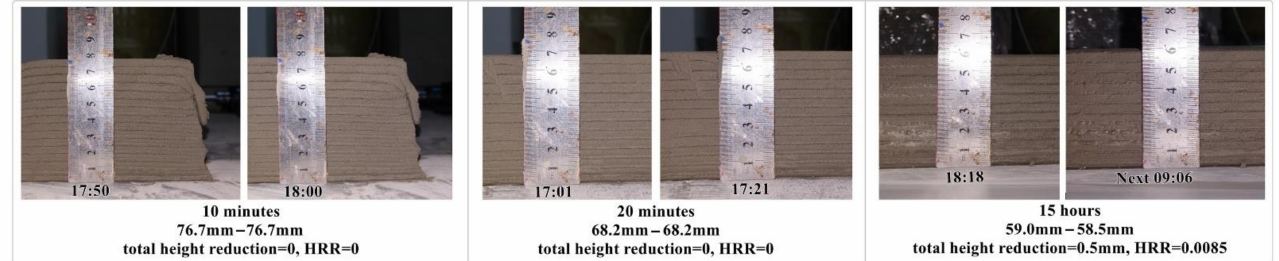
Figure 14. Results of the height reduction tests with different numbers of stacked layers.